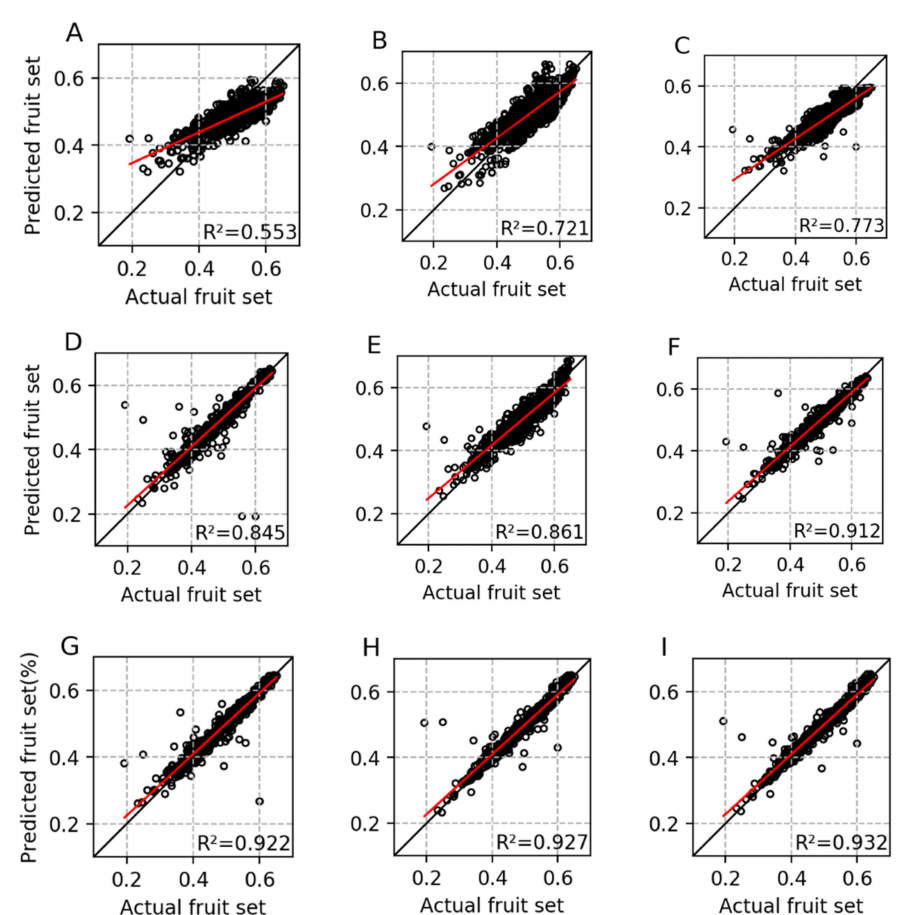
Figure 5. Scatter plots of actual fruit-set versus predicted fruit-set based on the wild blueberry pollination simulation validation dataset for MLR ( A ), SVR ( B ), AdaBoost ( C ), DT ( D ), ANN ( E ), KNN ( F ), RF ( G ), GBDT ( H ) and XGBoost ( I ). Black lines are 1:1 slopes and the red lines are least squares regression lines.